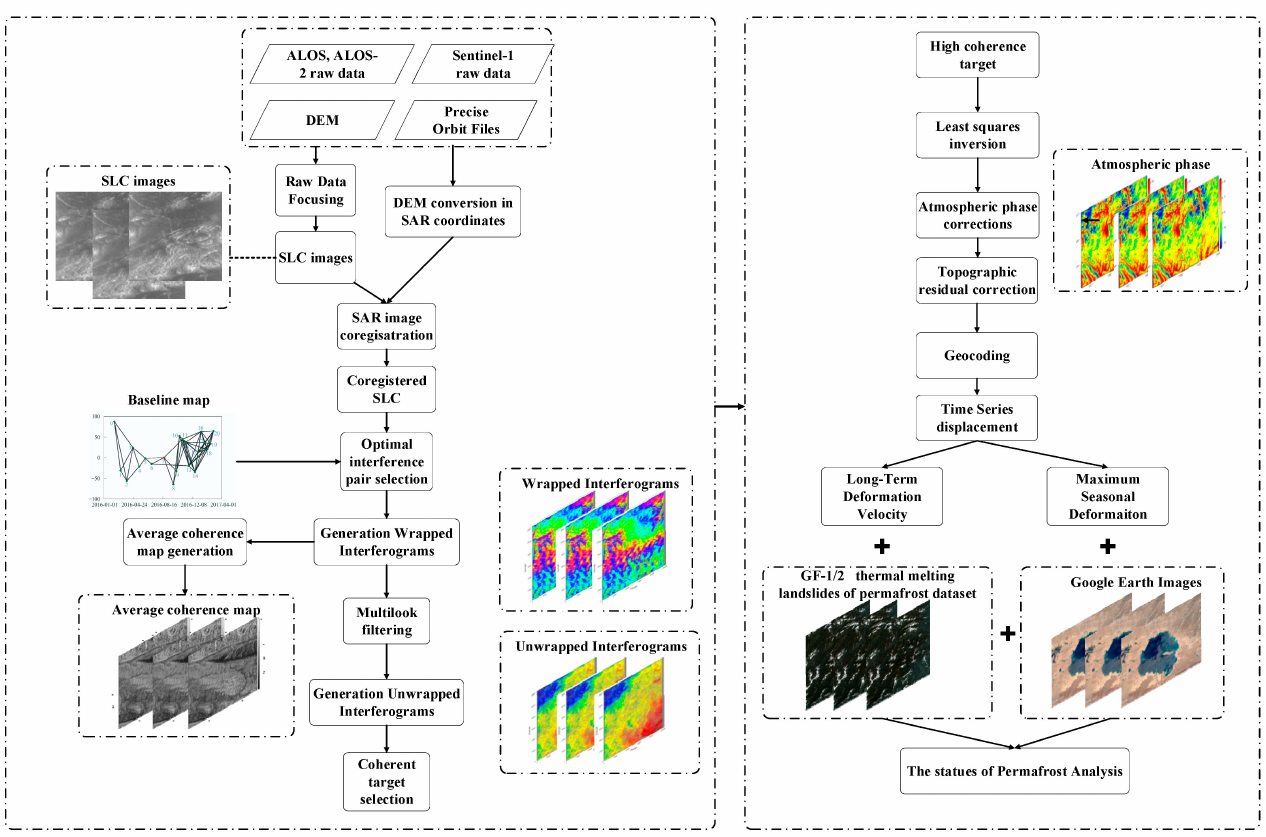
Figure 2. Flowchart of the processing